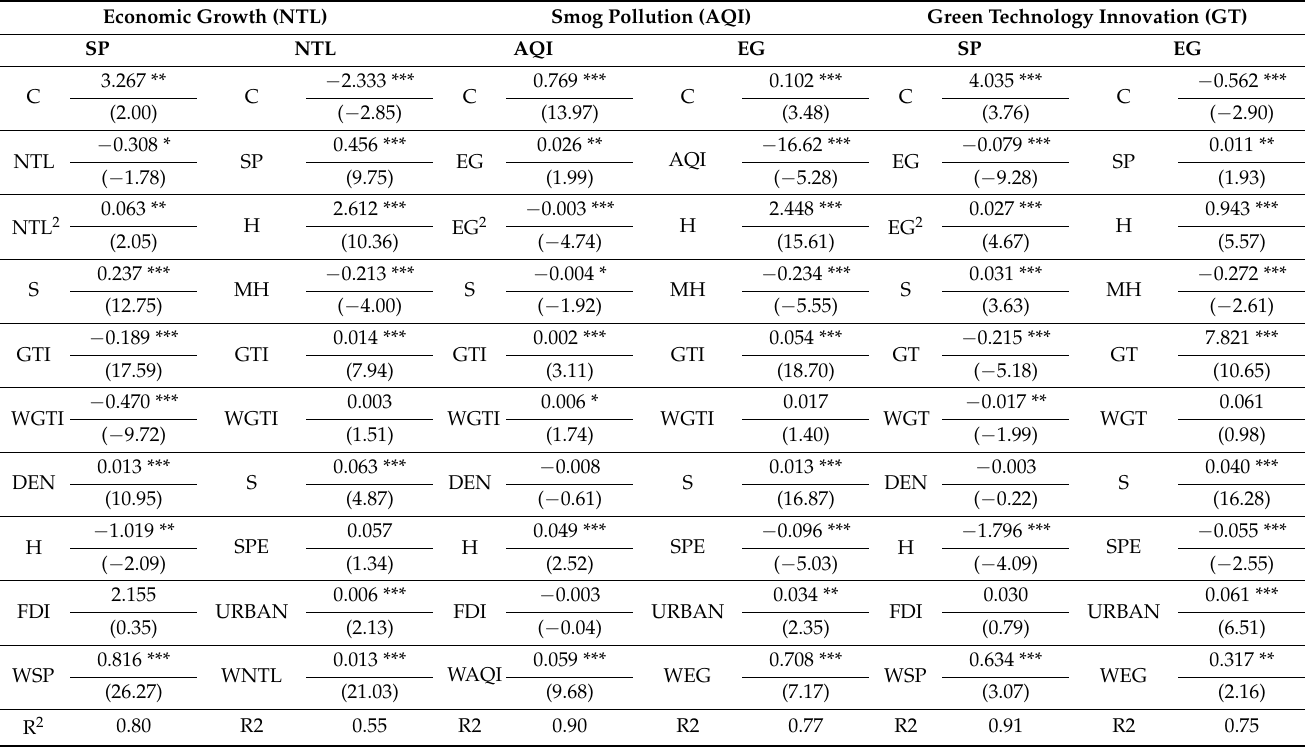
Table 7. Robustness test results of the impact of GTI on SP and EG.